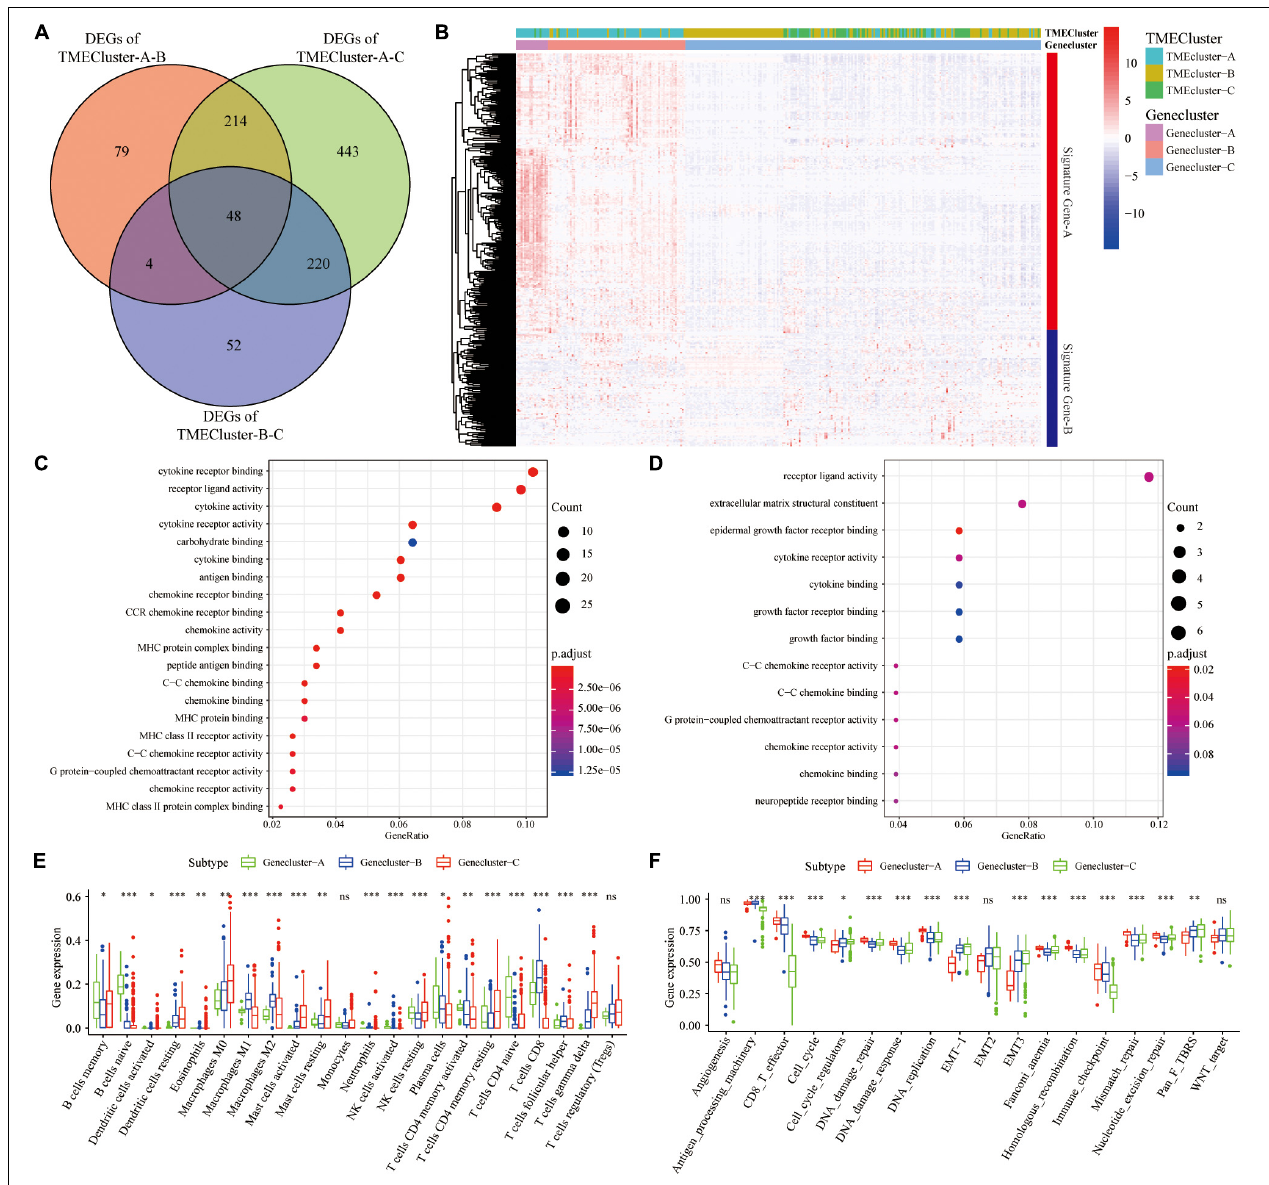
FIGURE 3 | Construction and functional annotation of TME-related characteristic genes. (A) The Venn diagram showing the DEGs between the three TME clusters in TCGA database. (B) Based on the gene expression profile of SKCM patients in the GEO database, unsupervised analysis and hierarchical clustering of DEGs were carried out, divided into GeneCluster-A, -B, and -C. According to their expression changes, DEGs were classified into Signature gene-A and -B. (C,D) Gene Ontology (GO) enrichment analysis of Signature gene-A (C) and -B (D) gene sets. (E) The expression of cells in the three GeneCluster groups. (F) The enrichment of different pathway characteristics (immune-related features, mismatch-related features, and matrix-related features) in three different GeneCluster groups ( ∗ p < 0.05, ∗∗ p < 0.01, ∗∗∗ p <